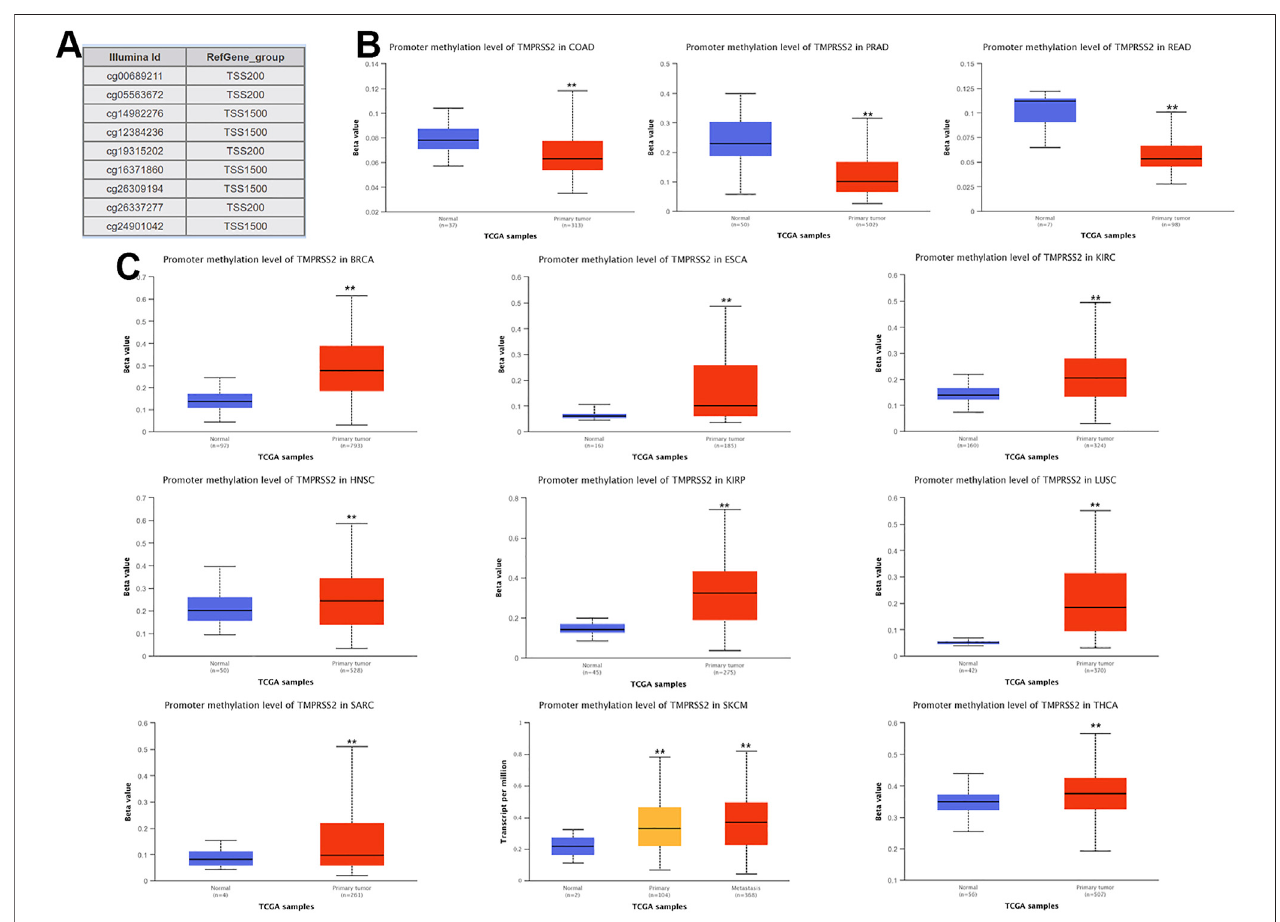
FIGURE 10 | Disease-free survival (DFS) data in malignant tumors with TMPRSS2 overexpression. (A) Survival picture of tumors overexpressing TMPRSS2; (B) DFS in TMPRSS2-overexpressing tumors.